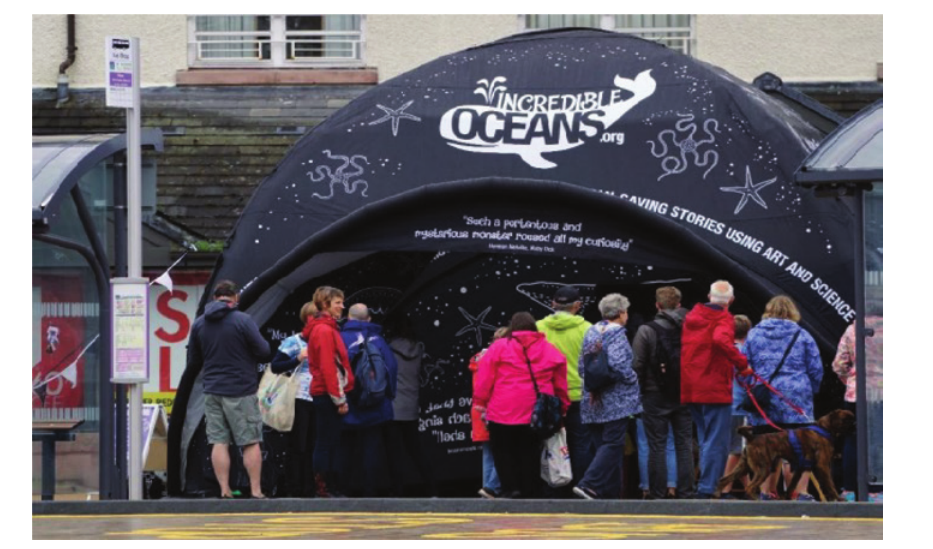
figure 6: The inflatable dome (credit: aquarela